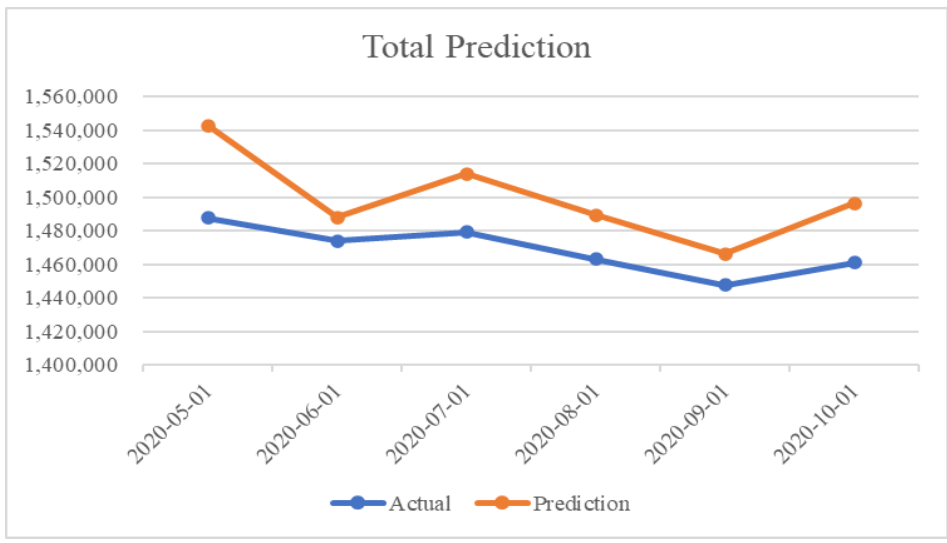
Figure 10. Multivariate LSTM prediction with time-series decomposition (x: date, y: TEU).